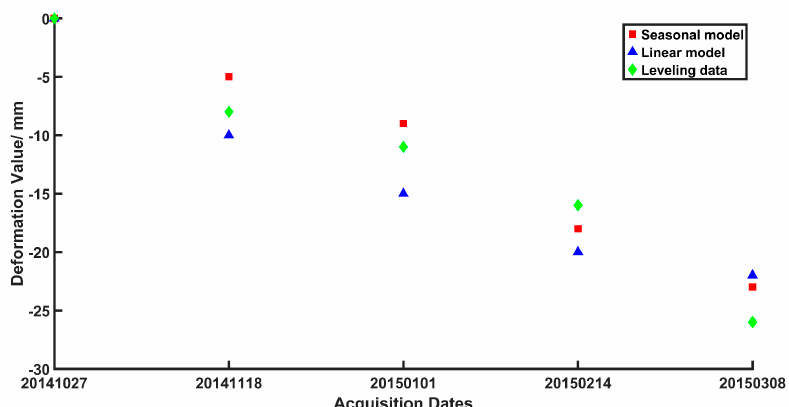
Figure 19. Time series deformation results compared with leveling measurements on K4 (the location is shown in Figure 9).